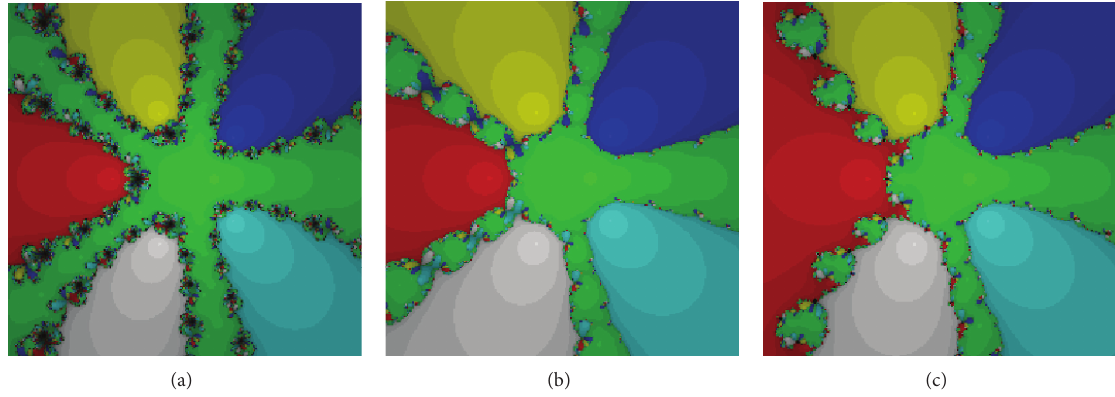
Figure 4: The basins of attraction for CM 2 4 (a), OM 4 (b), and MOM 4 (c) in problem 2.